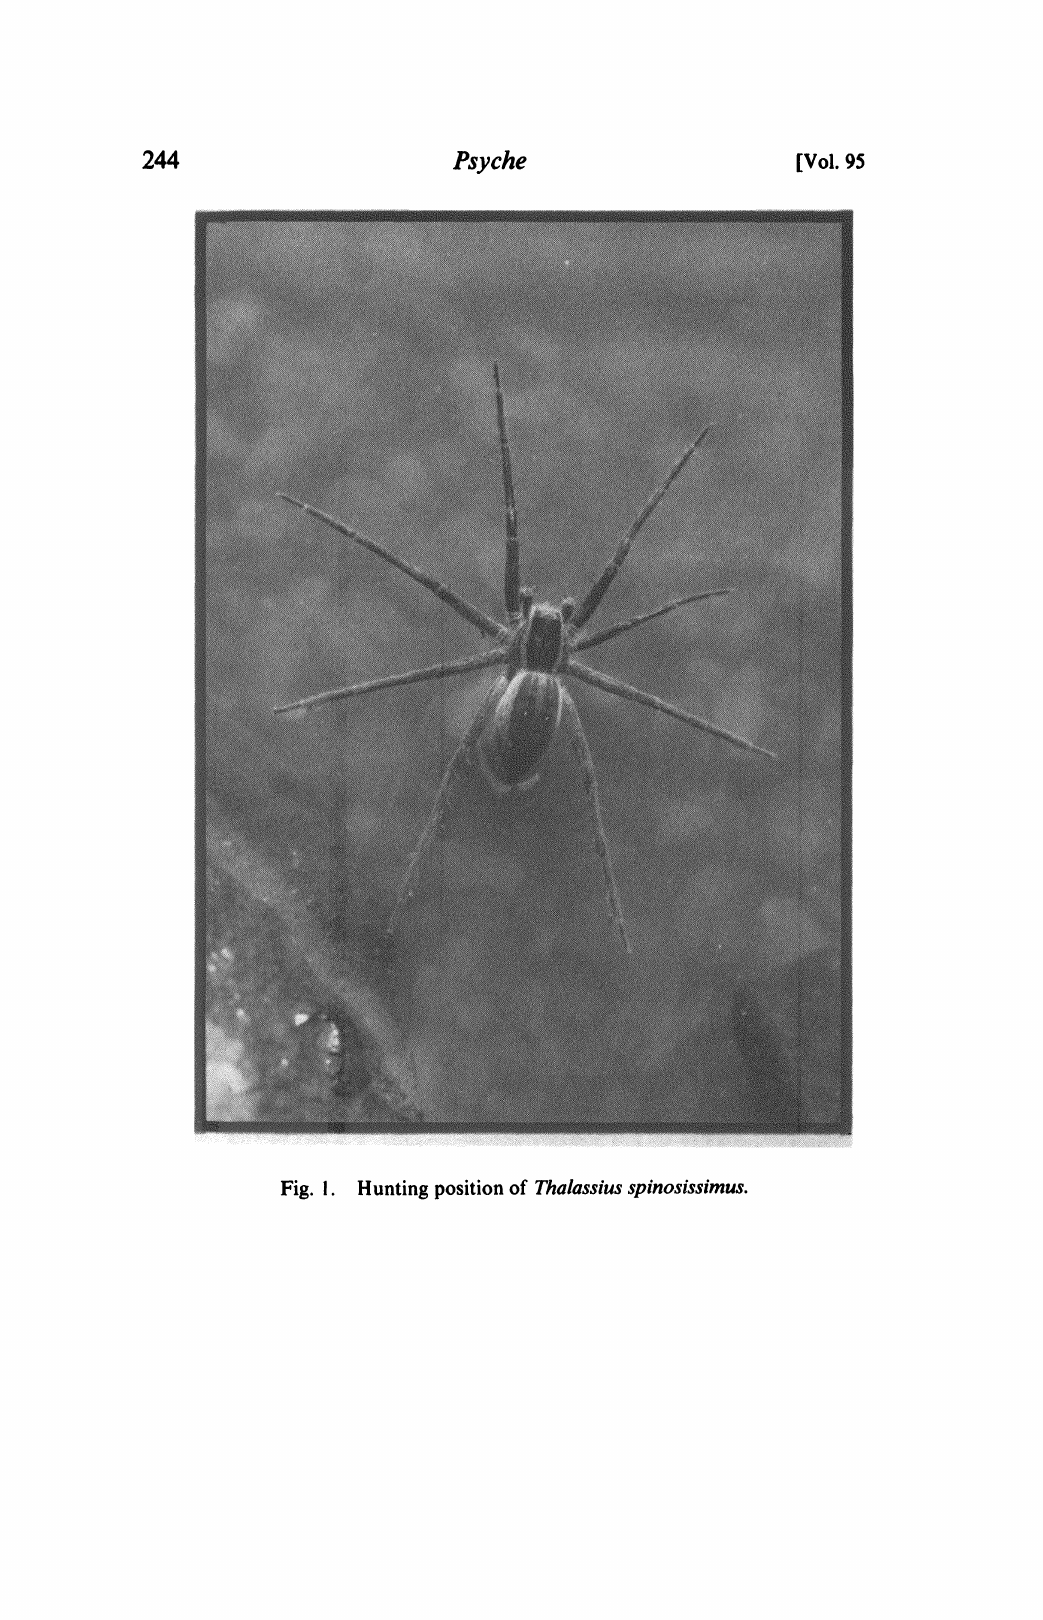
Fig. I. Hunting position of Thalassius